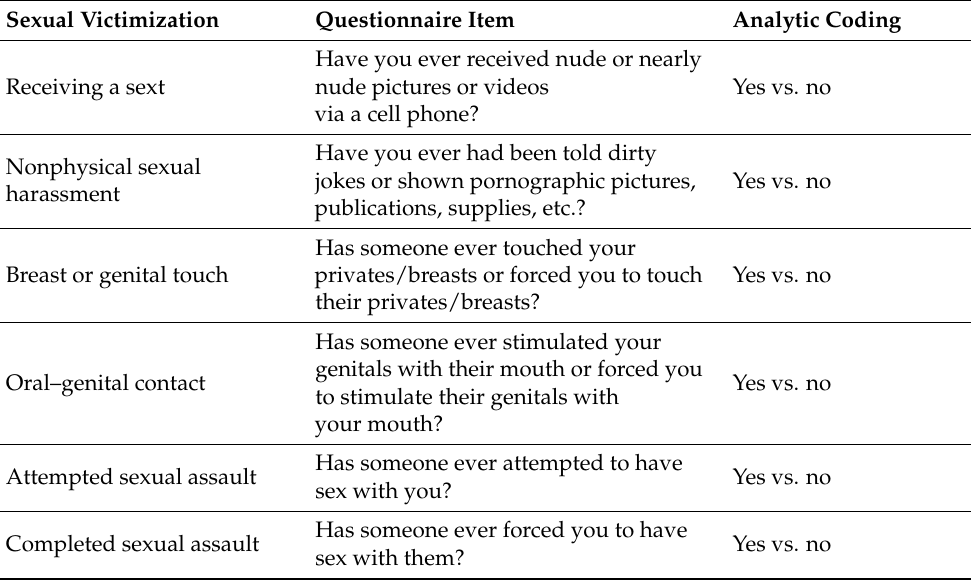
Table 1. Questionnaire items and analytic coding of sexual